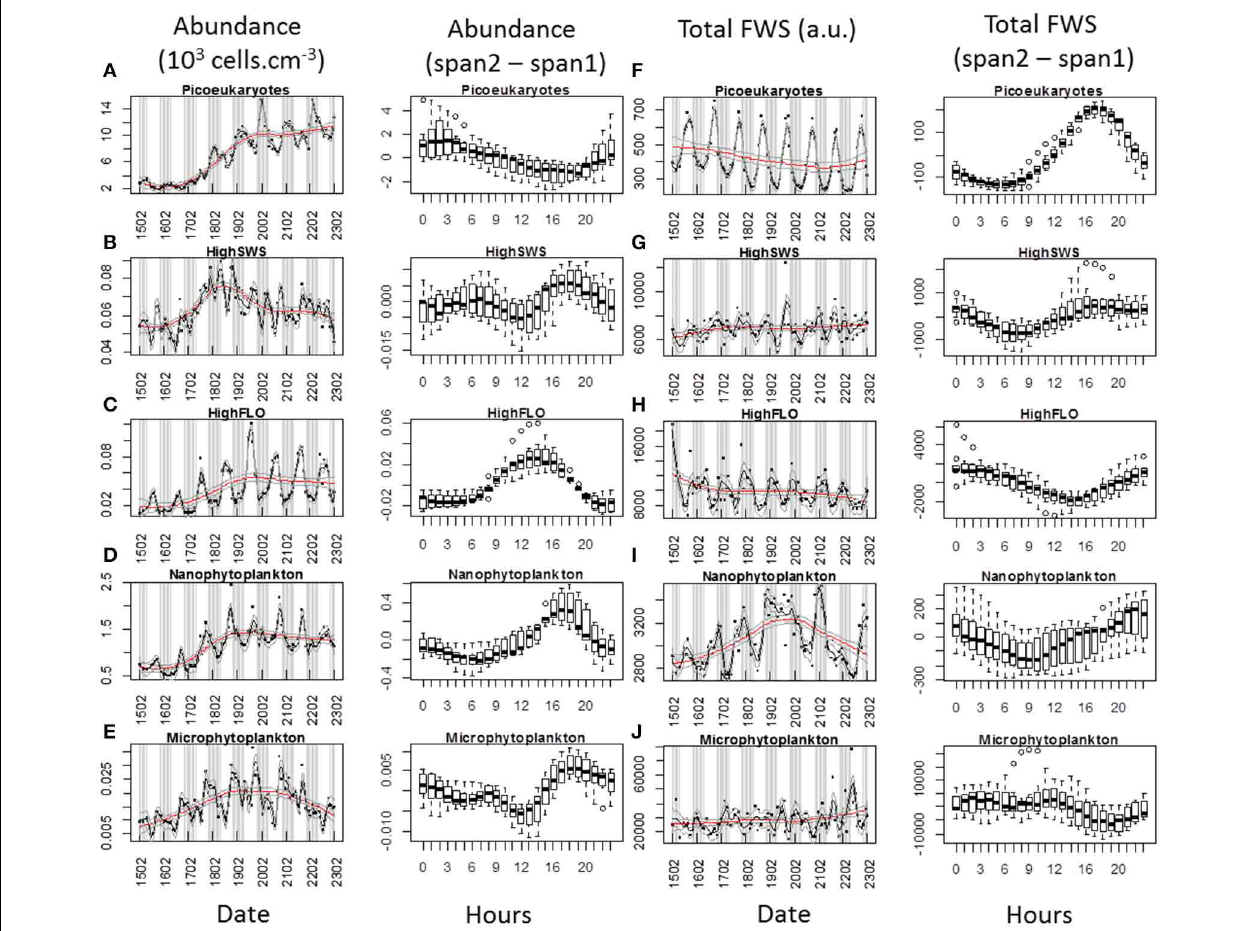
FIGURE 8 | Periodic variations of abundances and average Total FWS signals per cell for each cluster resolved with the CytoSense (except PicoFLO) during the first marked abundance pulse (February 15–22). The corresponding hourly box plots are displayed in parallel. Note the differences between a low span (gray line: span2) and a high span (red line: span1) loess